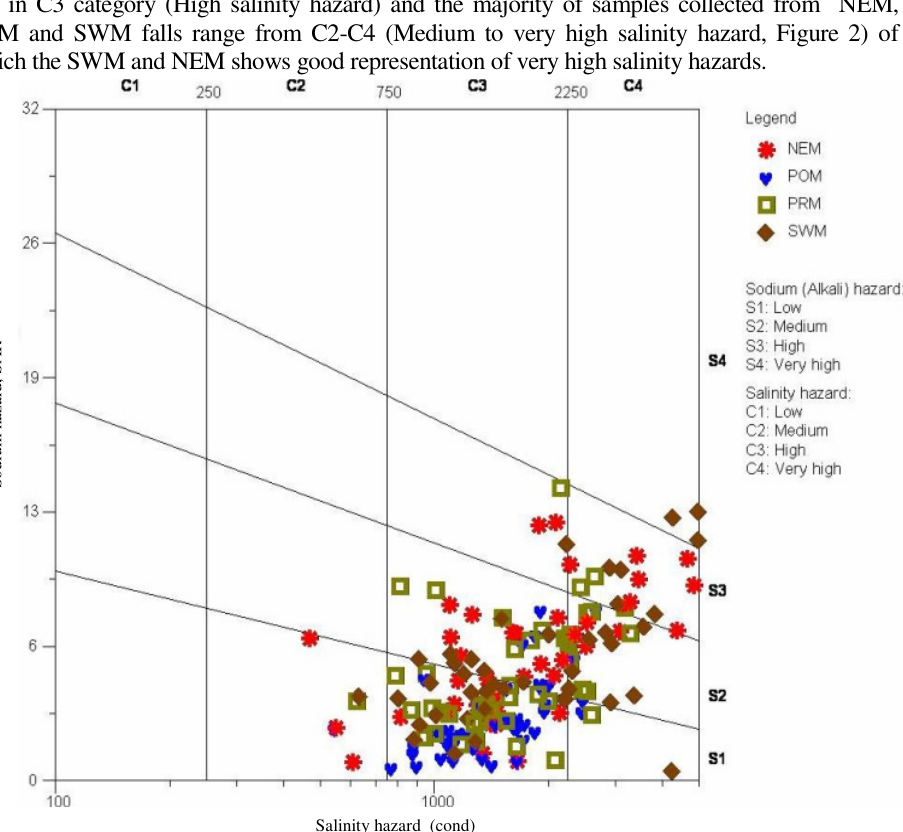
Figure 2. Wilcox classification of ground water for irrigation purpose (SAR: Sodium Adsorption